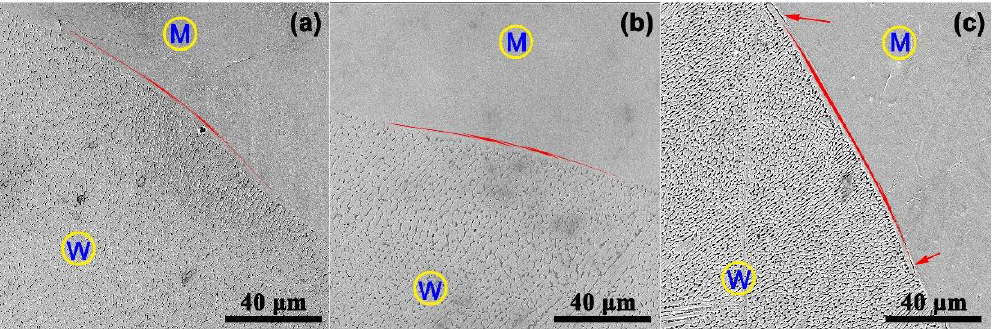
Figure 4. Transition region from weld to matrix. ( a ) W1; ( b ) W2; ( c ) W3 (the markers “M” and “W” denote the matrix and weld, respectively; the red line illustrates the fusion line and red arrows in ( c ) indicate the cracks).